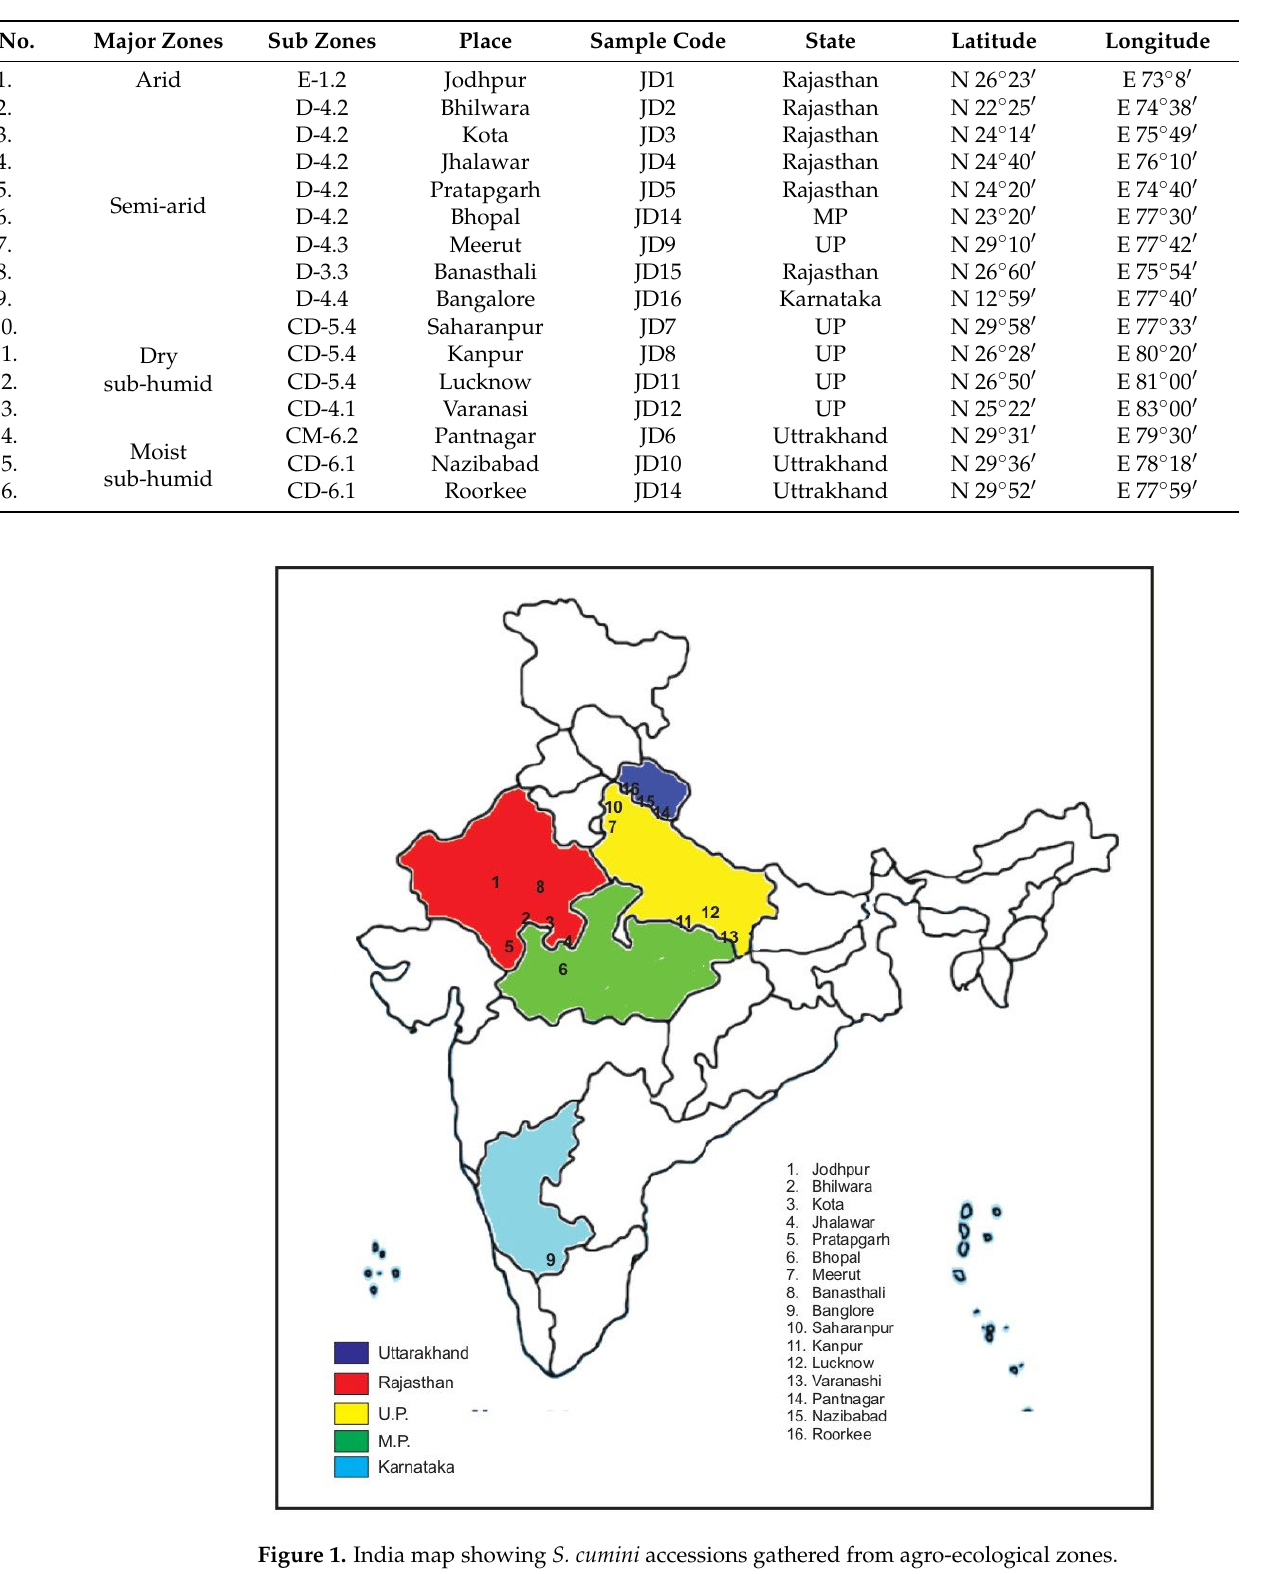
Table 1. Details of S. cumini samples gathered from diverse agro-ecological zones of India.